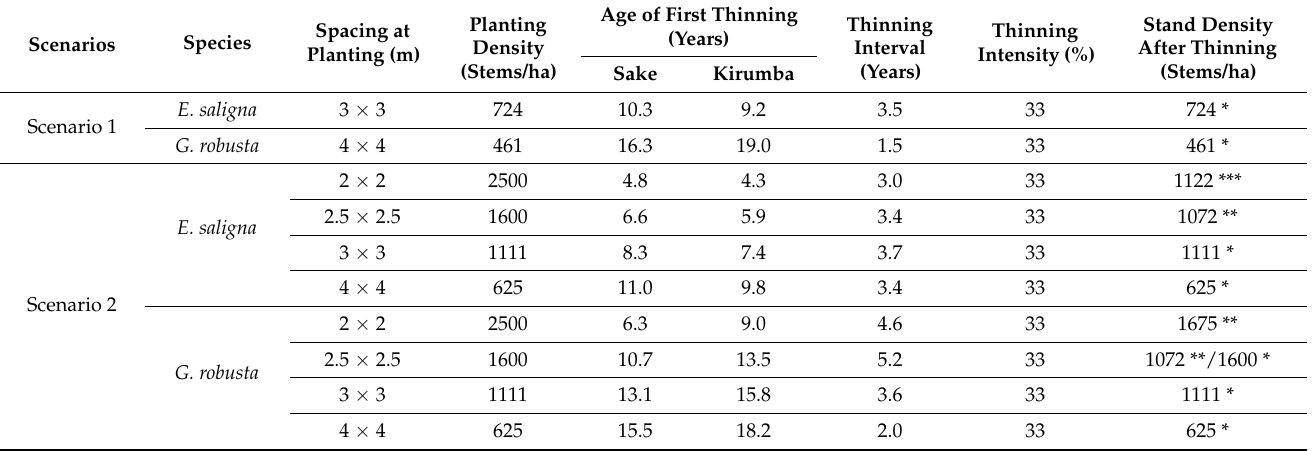
Table 4. Age, interval and intensity of thinning in E. saligna and G. robusta plantations in North Kivu. The age of first thinning was determined for each site from the threshold basal area (30 m 2 /ha) and stand density using Models 4 (for E. saligna ) and 9 (for G. robusta ). The asterisks indicate that